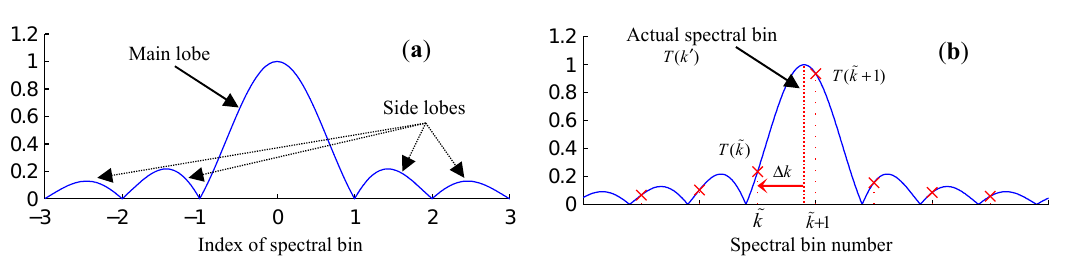
Figure 3. Rectangular window-based spectrum correction: ( a ) the magnitude response; ( b ) the spectral bins within the main lobe.